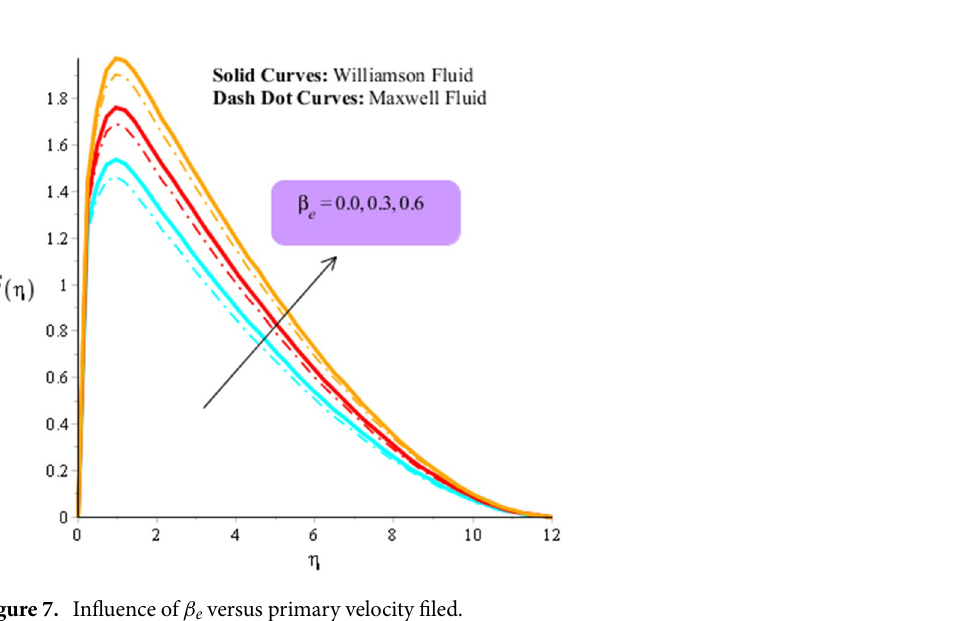
Figure 6. Influence of β i versus secondary velocity filed.